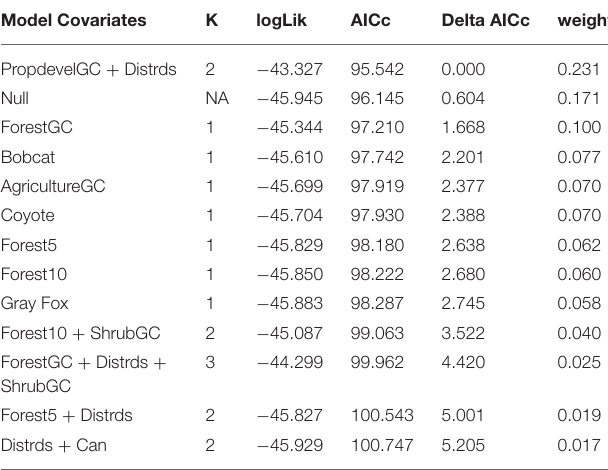
TABLE 4 | Candidate model set for U. cinereoargenteus .